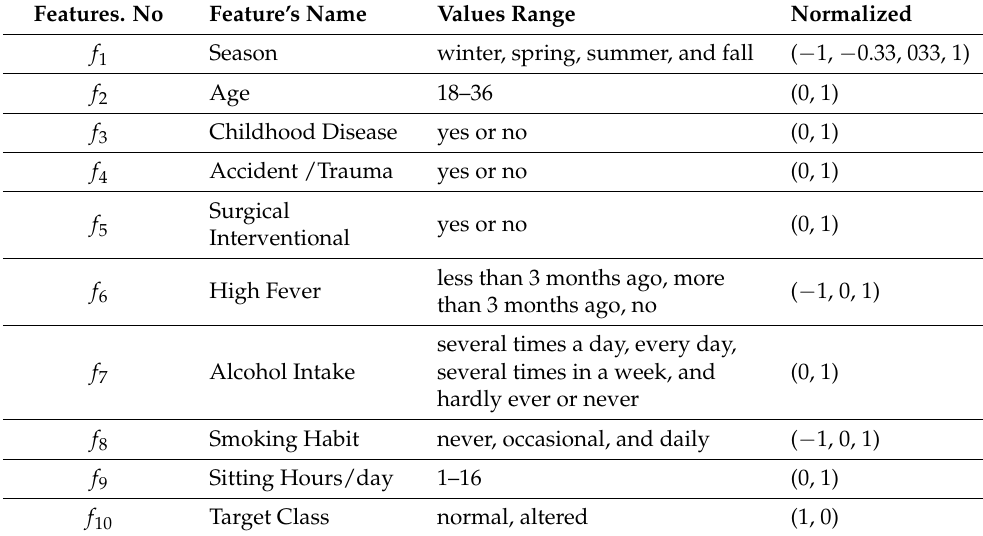
Table 1. Features with their